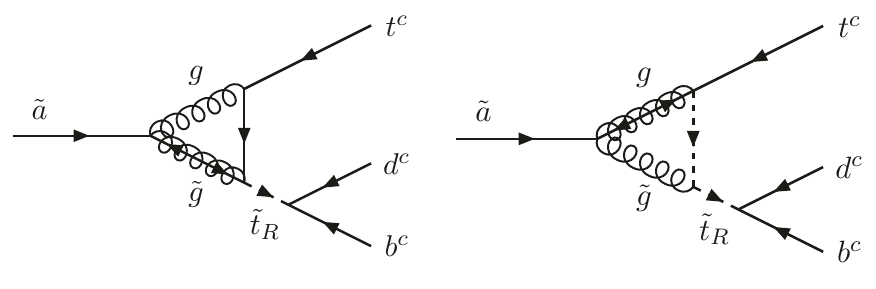
Figure 4 . The 1-loop diagrams for the decays of KSVZ type axino,